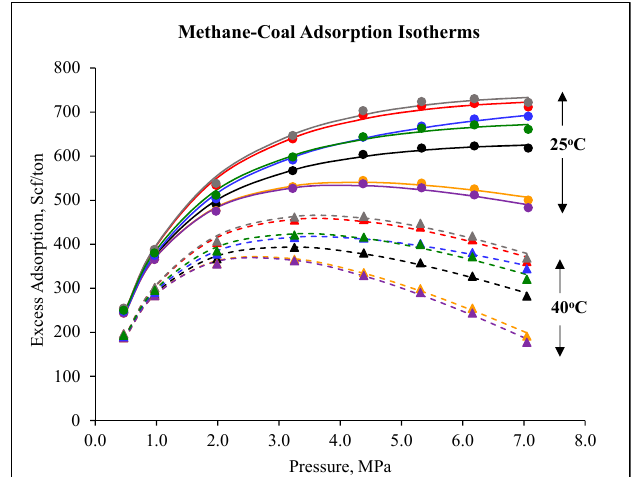
Figure 4. Methane-coal adsorption isotherms by equation of state (legends: markers = Excess adsorbed amount, lines = Langmuir fit; black = NIST-refprop, red = PR-EOS, brown = PR-Peneloux, orange = SRK-EOS, purple = SRK-Peneloux, blue = SBRW-EOS and green = Lee-Kesler).